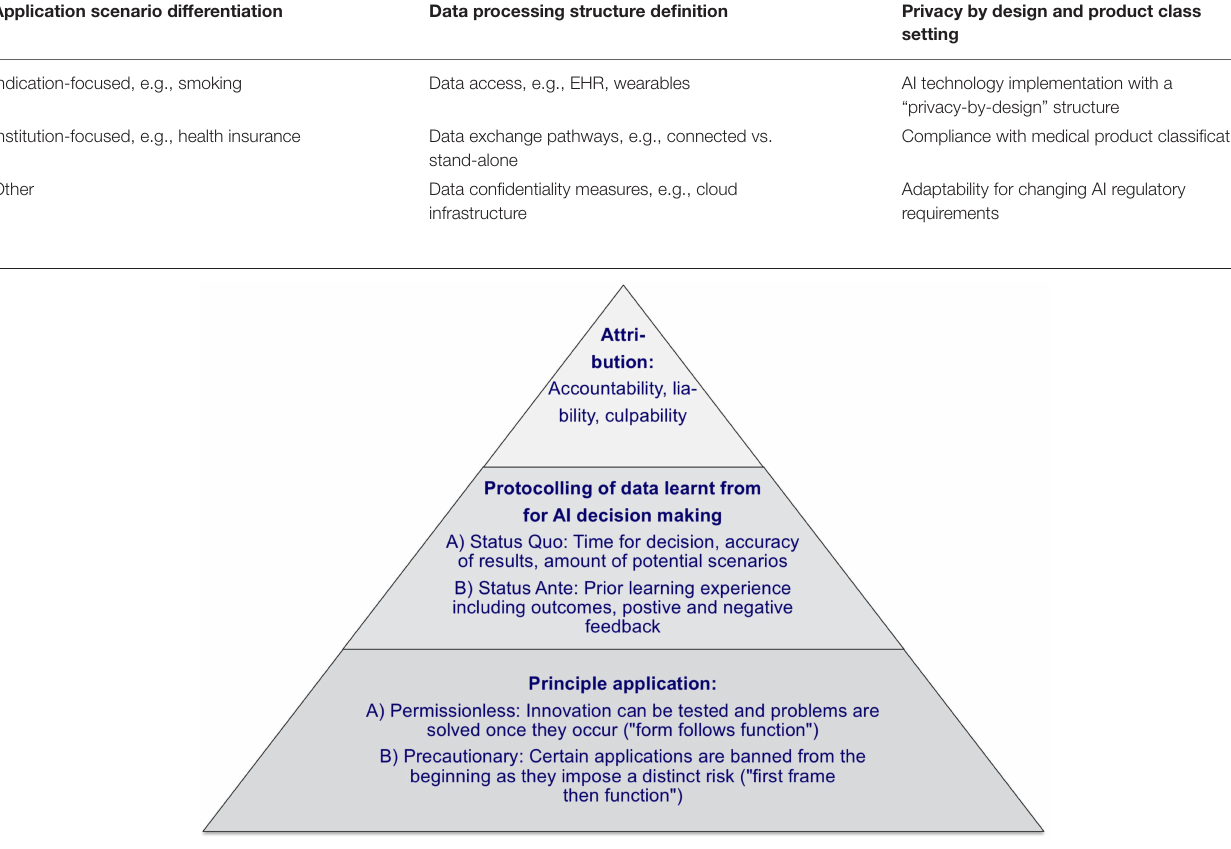
FIGURE 5 | Policy framework pyramid